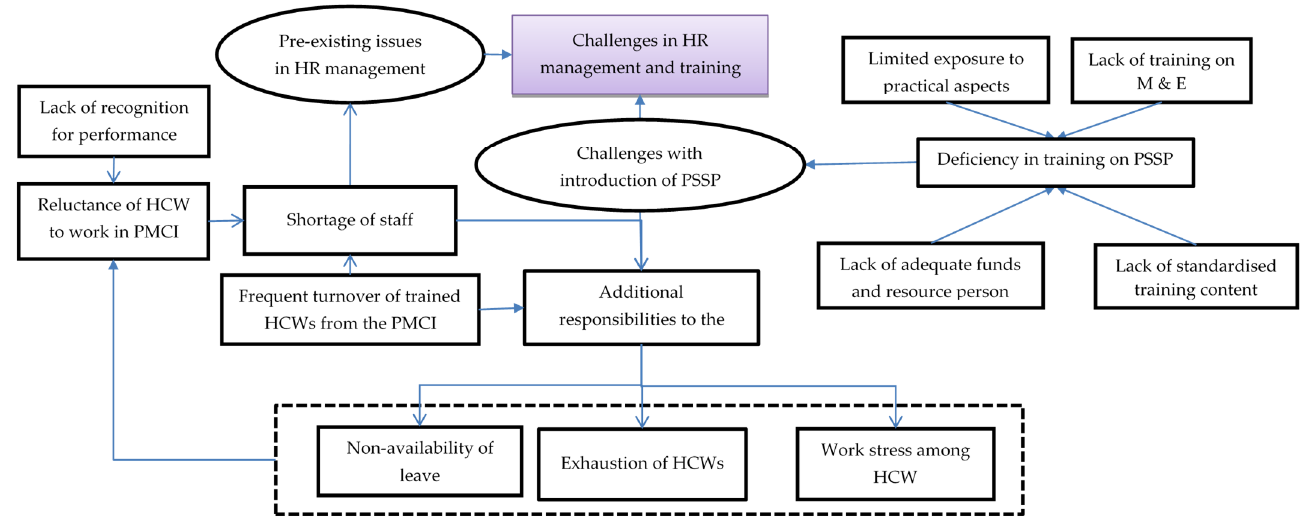
Figure 2. Challenges with human resource management and training in PMCIs supported by PSSP in Sri Lanka, 2021. Abbreviation: HCWs: Healthcare Workers; PMCI: Primary Medical Care Institution; PSSP: Primary Healthcare-System-Strengthening Project (PSSP); M and E: Monitoring and Evaluation.